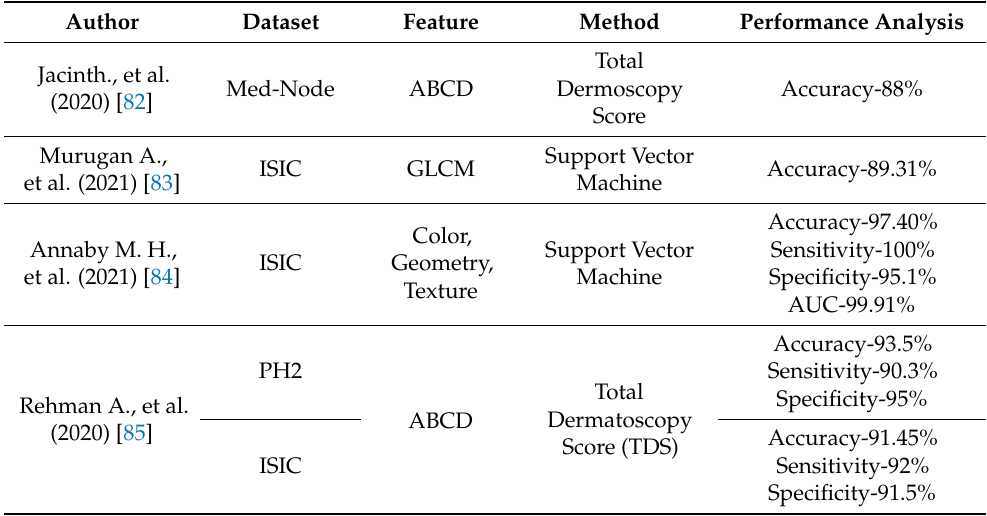
Table 5. The different types of skin cancer image feature